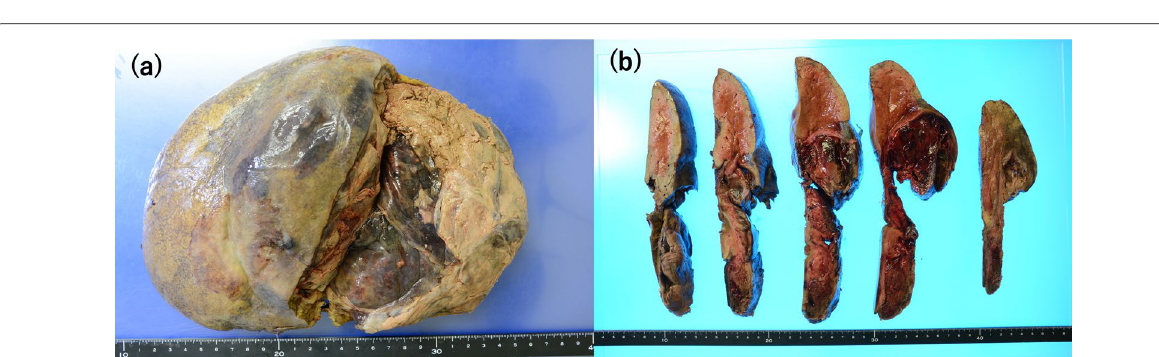
Fig. 3 a and b A resected specimen reveals a well-encapsulated cyst with mural nodules